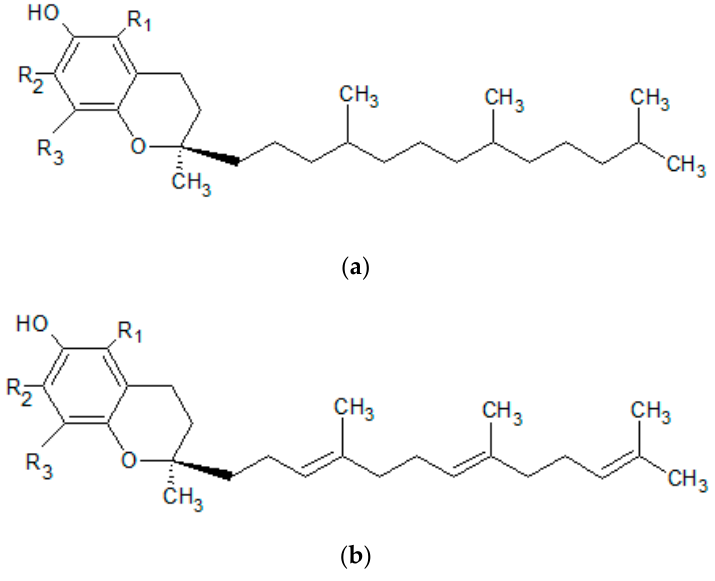
Figure 4. Basic structure of ( a ) tocopherols and ( b ) tocotrienols (own work). Vitamin E is exclusively synthesized by plants [76], and all forms are supplied to the human body by food (Table 1). Alpha-tocopherol is the most important form, showing an affinity for the specialized protein alpha-TTP, which binds and transports this form of the vitamin only. The remaining dietary forms are metabolized in the liver and eliminated from the body with bile [79,80].